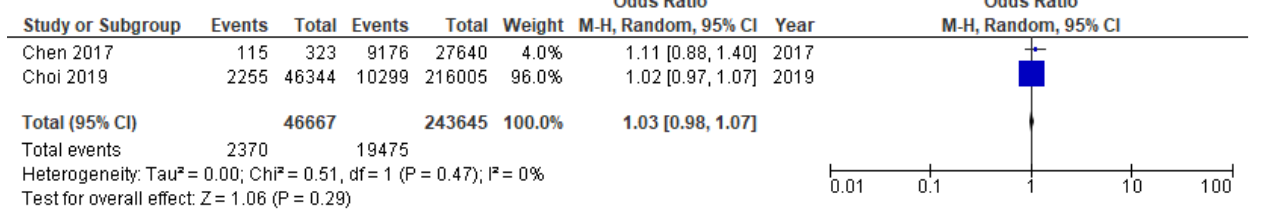
Figure 7. Sensitivity post-hoc analysis to determine the robustness and consistency of main meta- analysis results [133,139]. Forest plot for the association between periodontitis and Alzheimer’s disease (primary outcome) in two cohort studies.